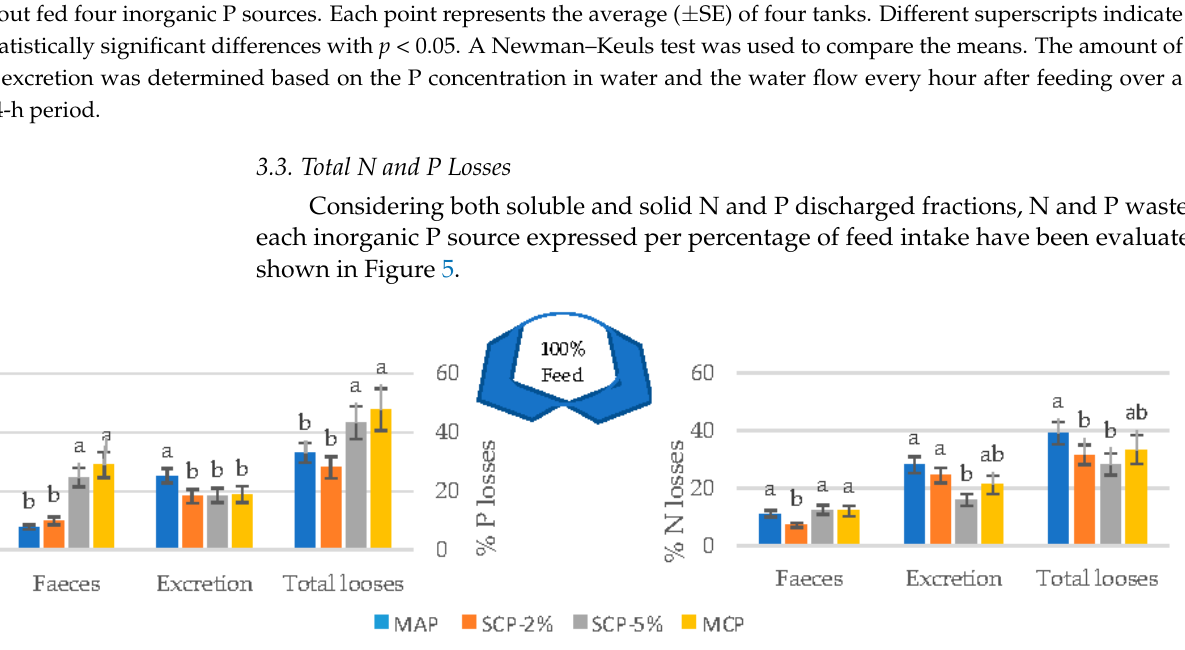
Figure 5. Nutrient mass budget for N and P expressed as a percentage of the amount of dietary nutrient provided to fish. Each point represents the average ( ± SE) of four tanks. Different superscripts indicate statistically significant differences with p < 0.05. A Newman–Keuls test was used to compare the means.